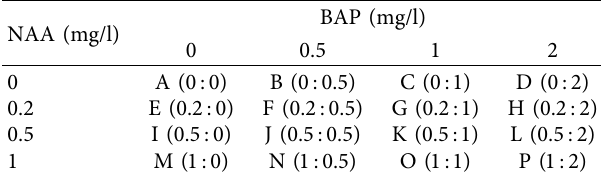
Table 1: NAA: BAP